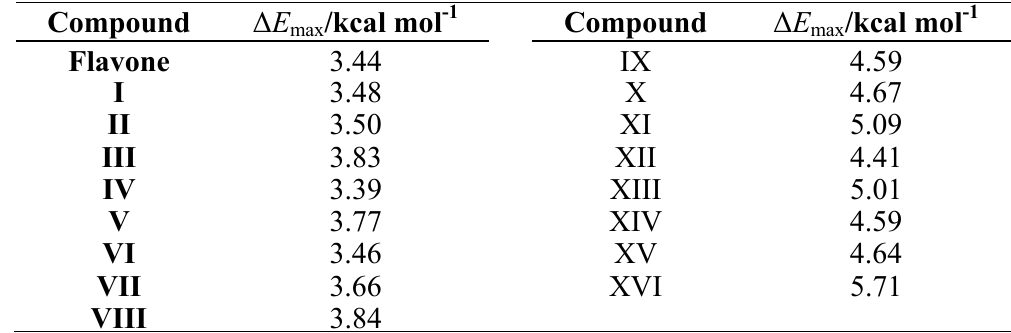
Table 3. Maxima of the torsional barrier, Δ E dihedral angle in the studied flavonoids computed in gas phase at the B3LYP/6-311++G** theoretical level. All the maxima appear at τ = 90° (Figure